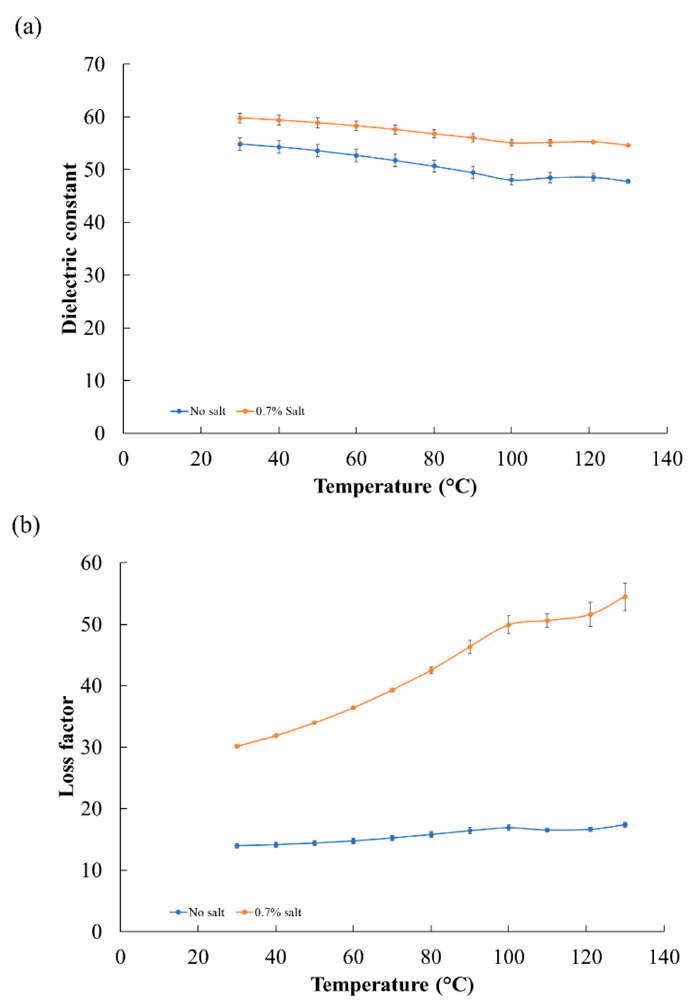
Figure 5. Dielectric properties of potato–rice-based model foods: ( a ) dielectric constant and ( b ) loss factor.